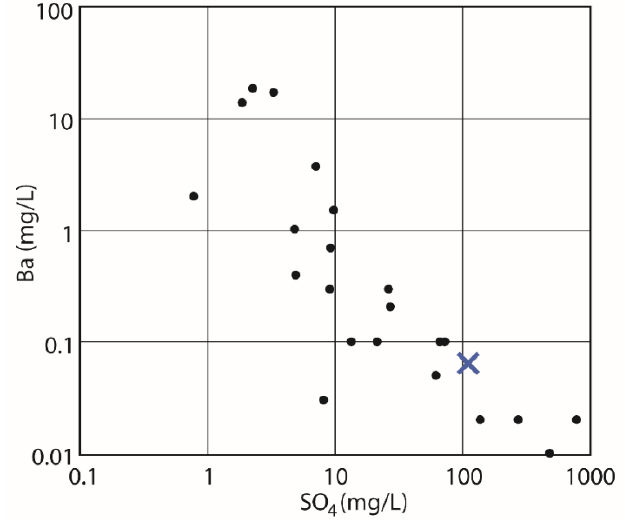
Figure 5. Comparison of some water samples with different concentrations of sulfates and Ba (modified after [55]). The Žvepovnik spring is marked with the blue cross (X).